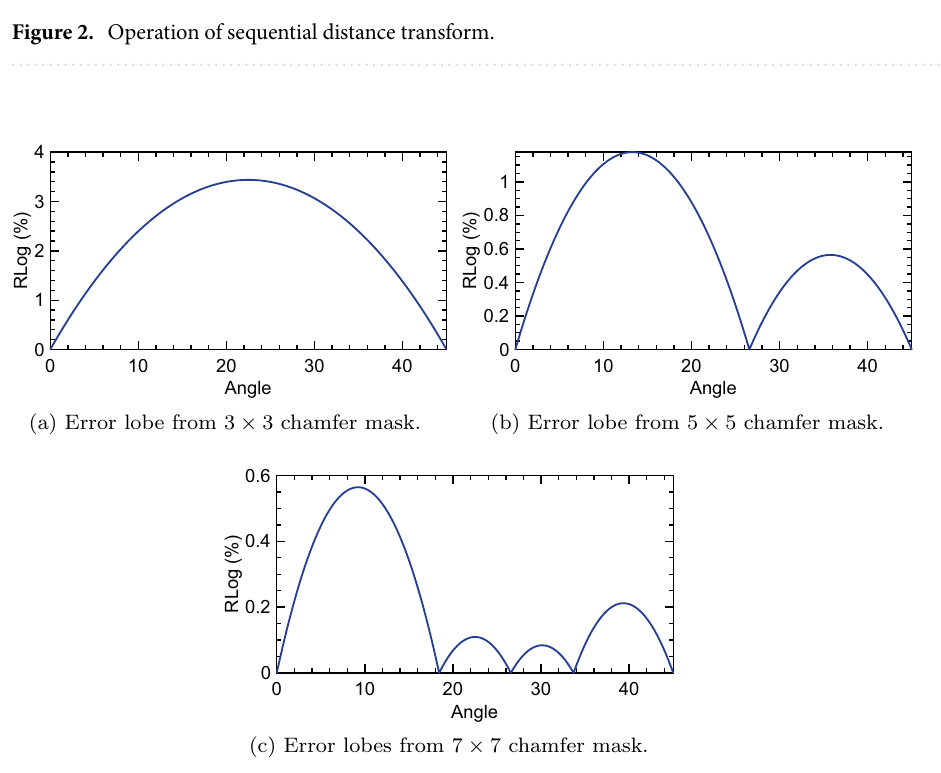
Figure 3. RLog error lobes generated by low-order chamfer